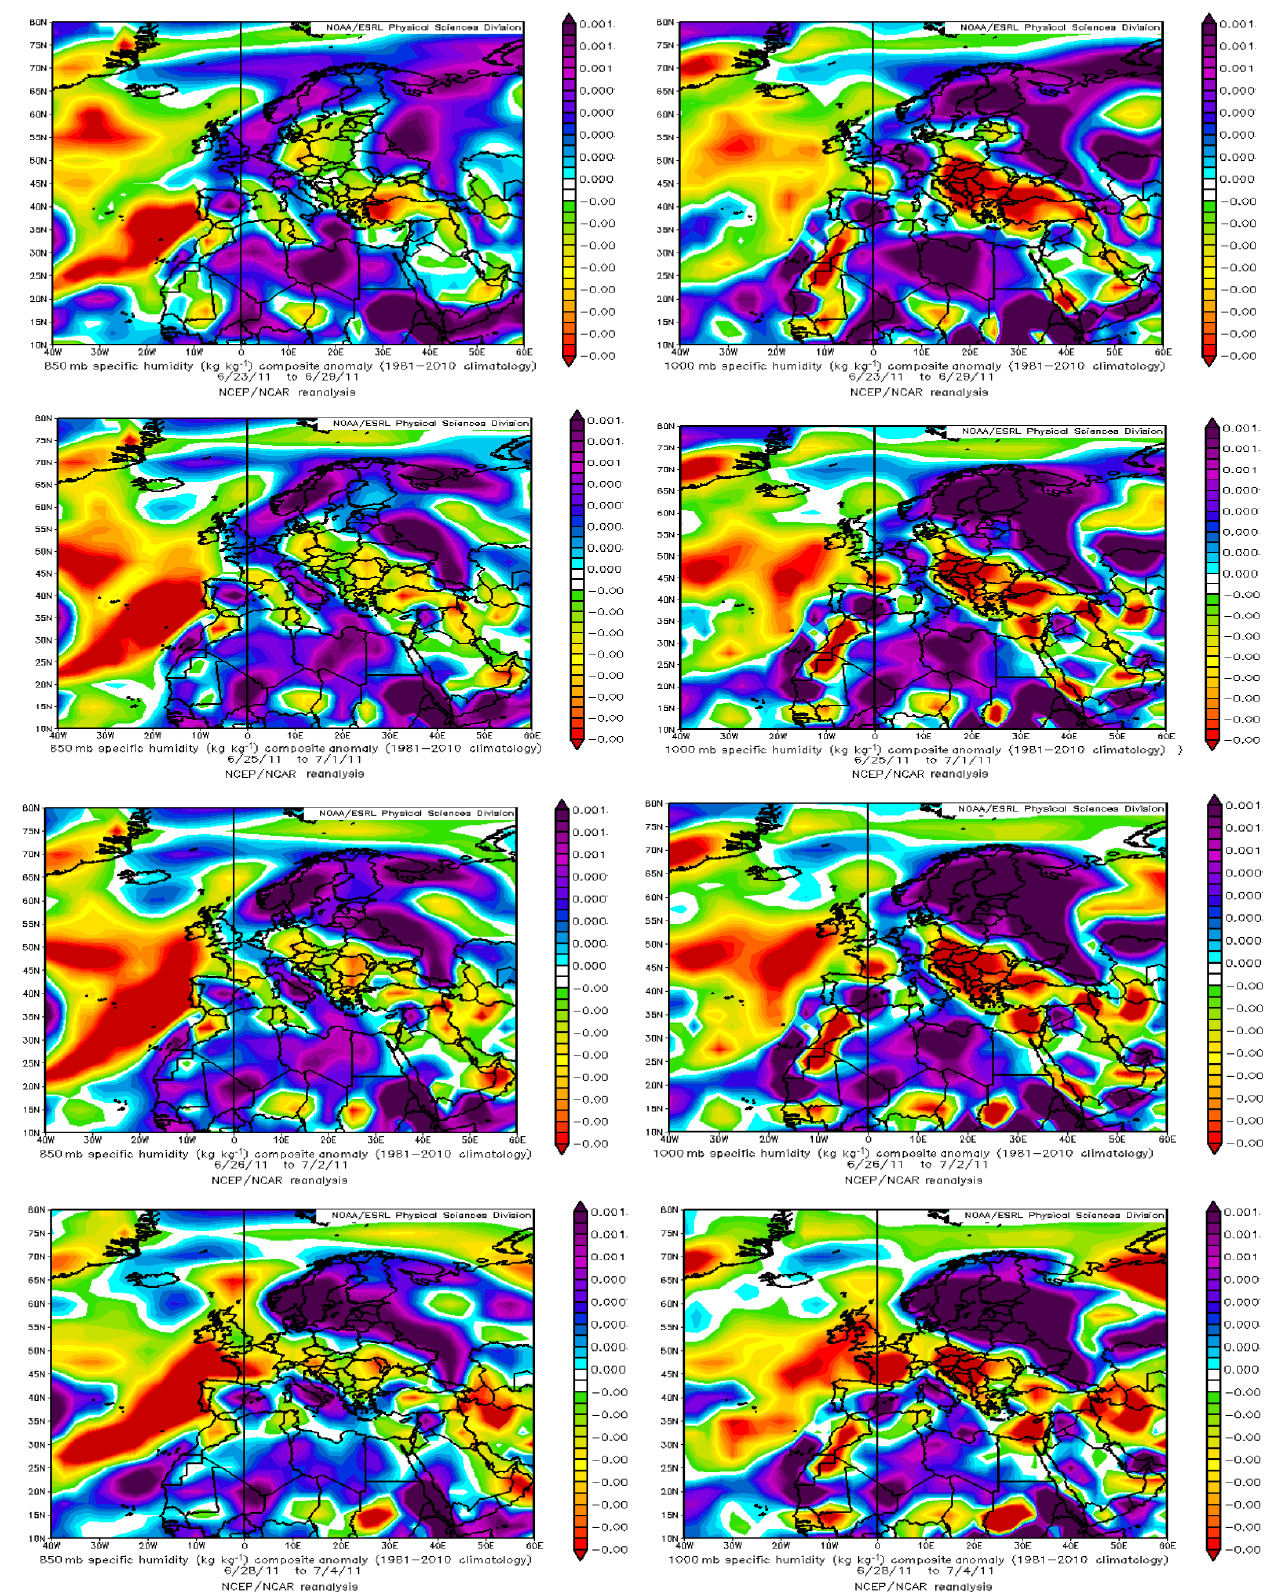
Figure 8. Composite charts for specific humidity anomaly at 850hPa (left column) and at 1000hPa (right column), 5, 3 and 2d before and during the episode of 28 June–4 July 2011 (lower